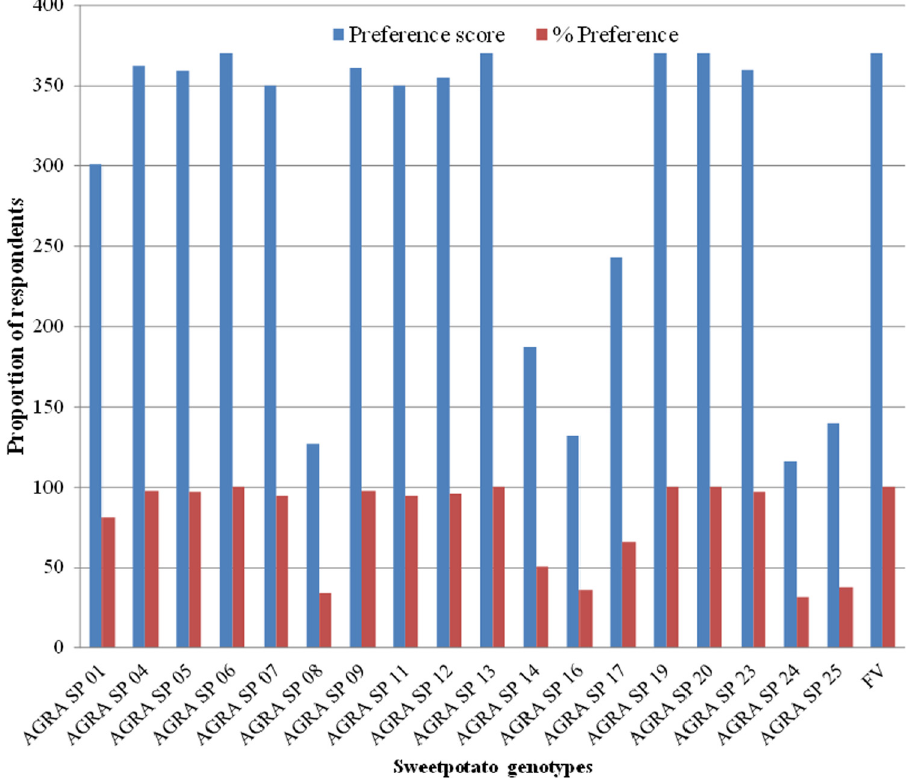
Figure 1: Cooking quality preferences for the sweetpotato genotypes across ecozones over two